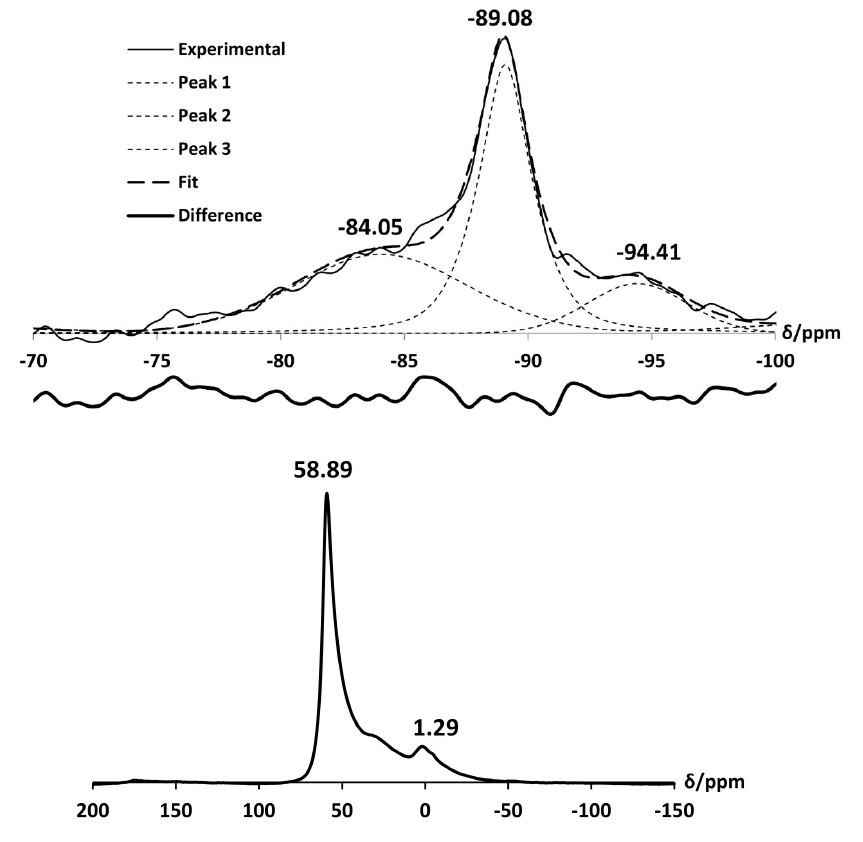
Figure 9. 29 Si (top) and 27 Al (bottom) NMR spectrum of the monovalent cation-exchanged NH 4